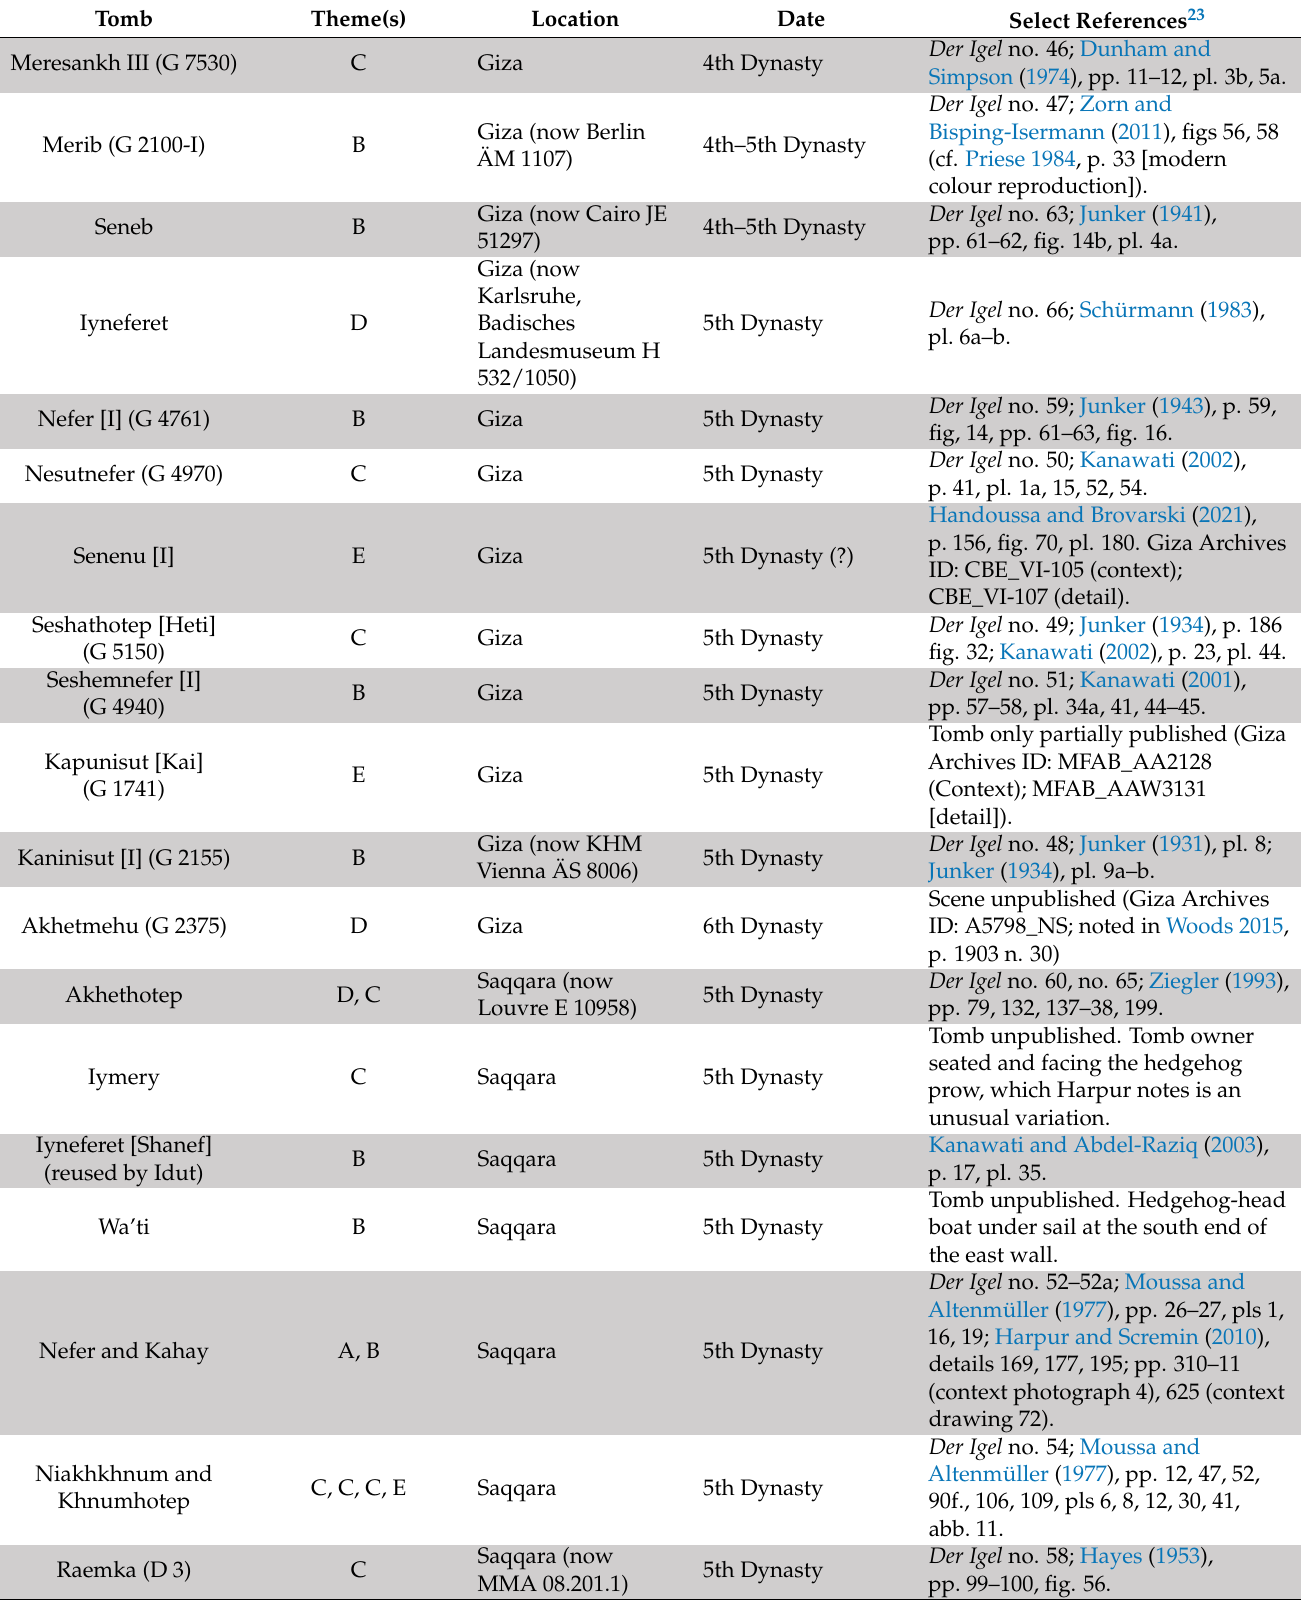
Table 1. Hedgehog-head boats represented in Old Kingdom